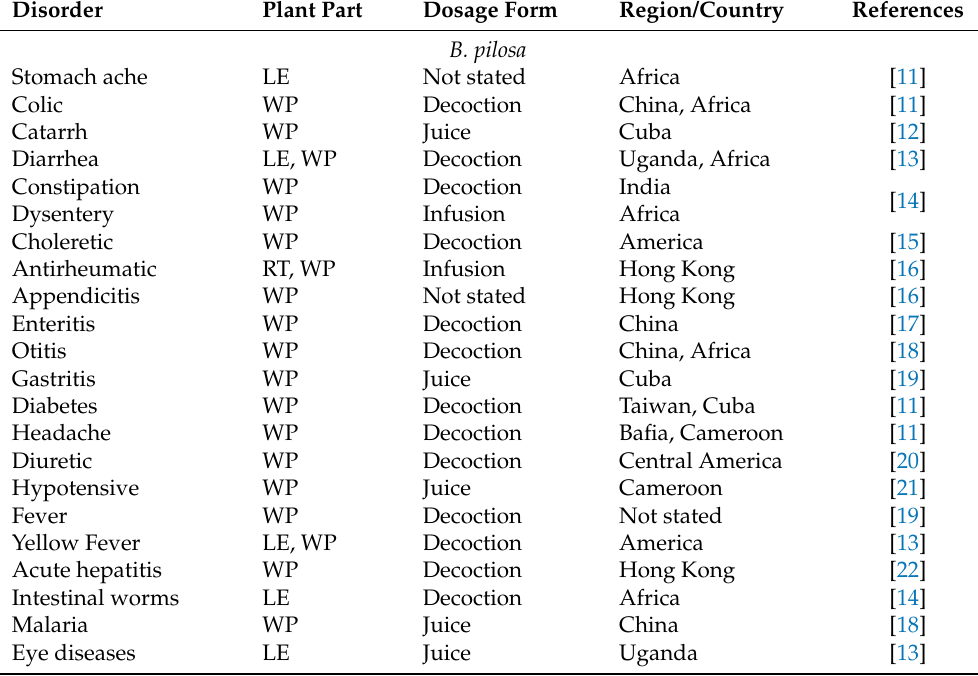
Table 1. Ethno-medical evidence about B. pilosa , B. biternata, and B. bipinnata .